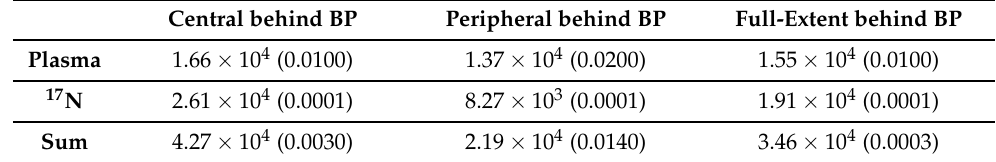
Table 2. Total neutron flux [n/cm 2 /s] (MCNP relative error) in BP tallies (Plasma + 17 N). Central behind BP Peripheral behind BP Full-Extent behind BP